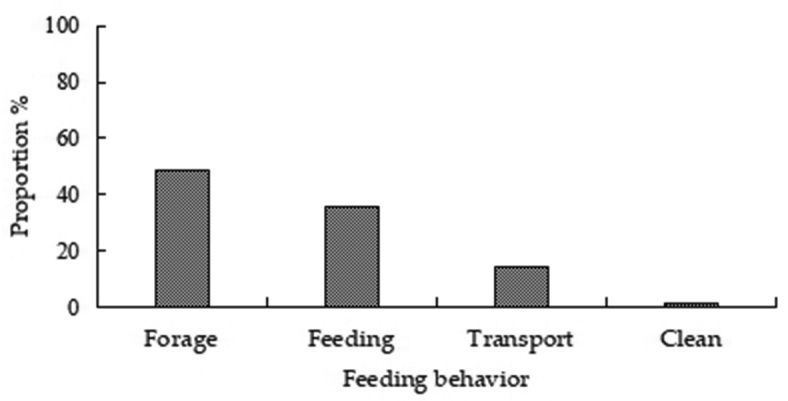
Proportion of feeding behaviors of A.
peninsulae.